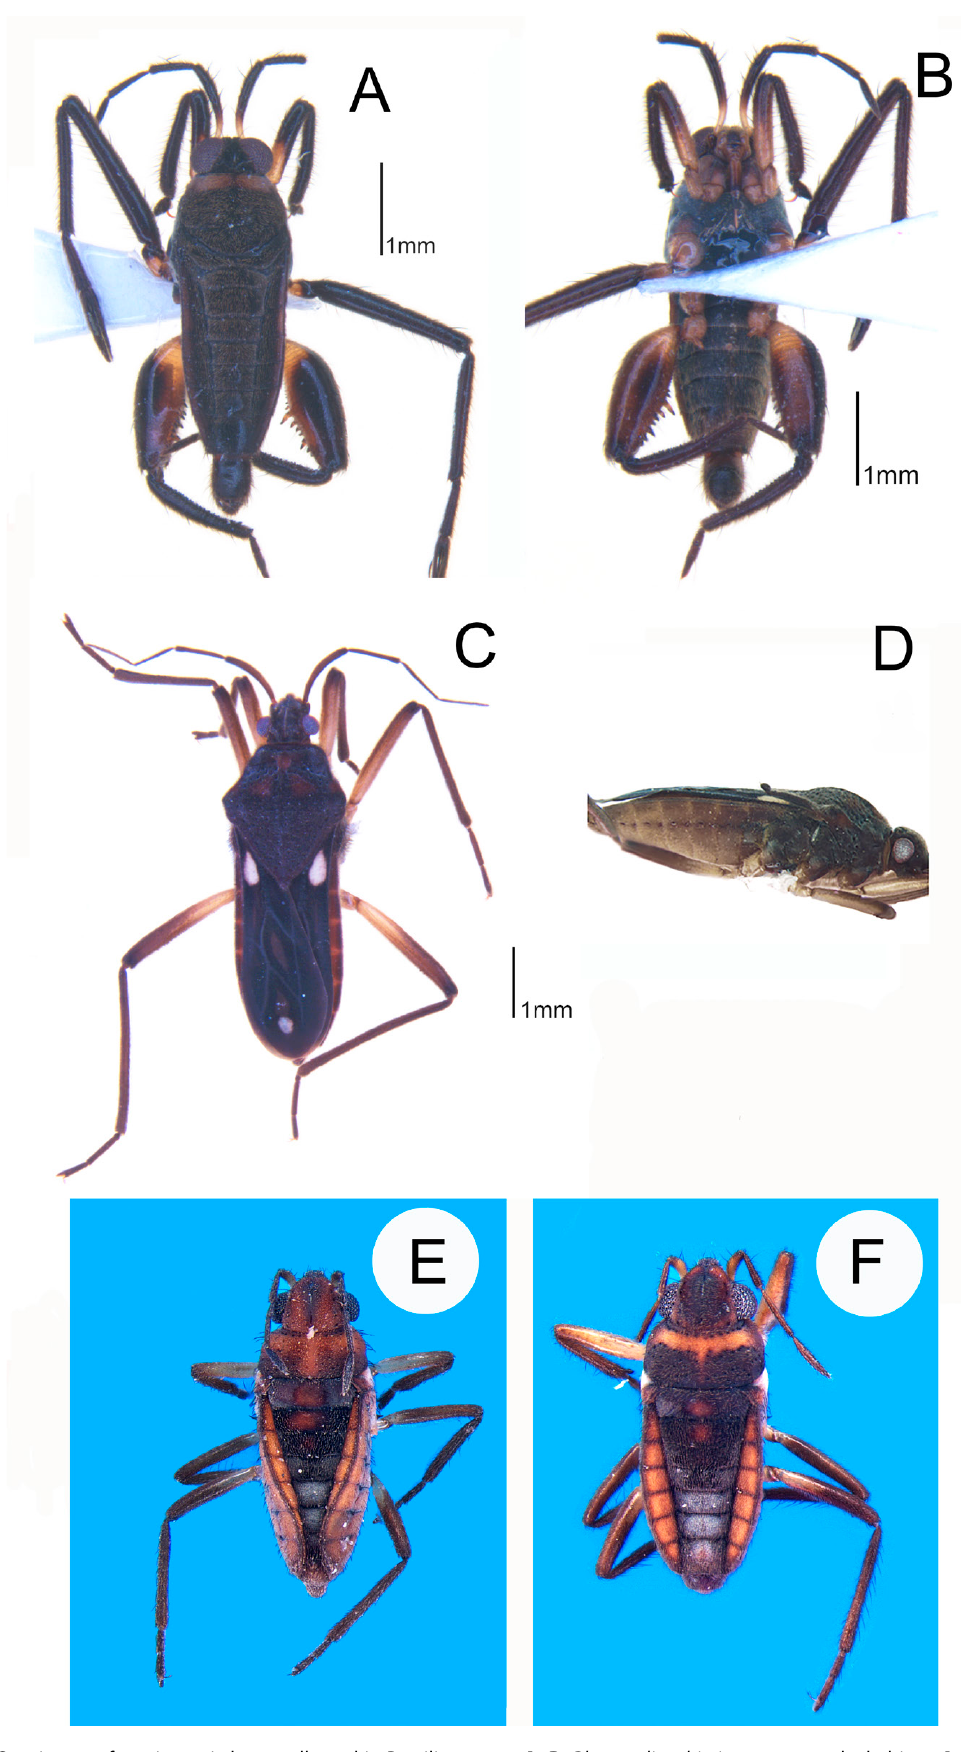
Figure 12. Specimens of semiaquatic bugs collected in Brazilian caves. A, B. Rhagovelia whitei , apterous male, habitus. A. Dorsal view. B. Ventral view. C, D. Paravelia digitata , macropterous male, habitus. C. Dorsal view. D. Lateral view, anterior portion of head and apex of abdomen omitted. E, F. Microvelia ioana , habitus, dorsal view. E. Female. F.